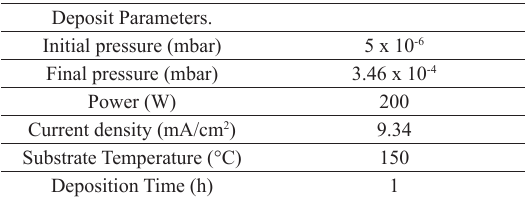
Table 1. Deposition conditions of the (Ti, Al, N) Si films. Deposit Parameters.